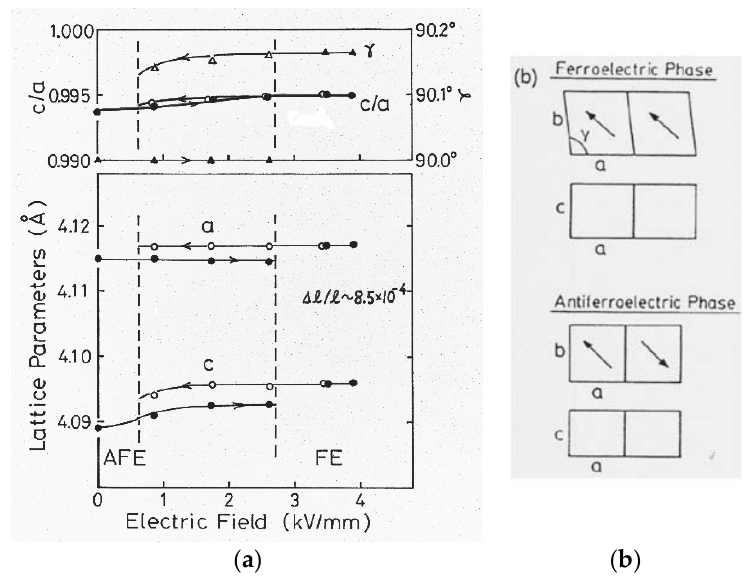
Figure 6. ( a ) Variation of lattice parameters with bias electric field at room temperature (y = 0.06); and ( b ) two-sublattice model of the polarization configuration for the AFE and FE states. (After Uchino and Nomura [7]).